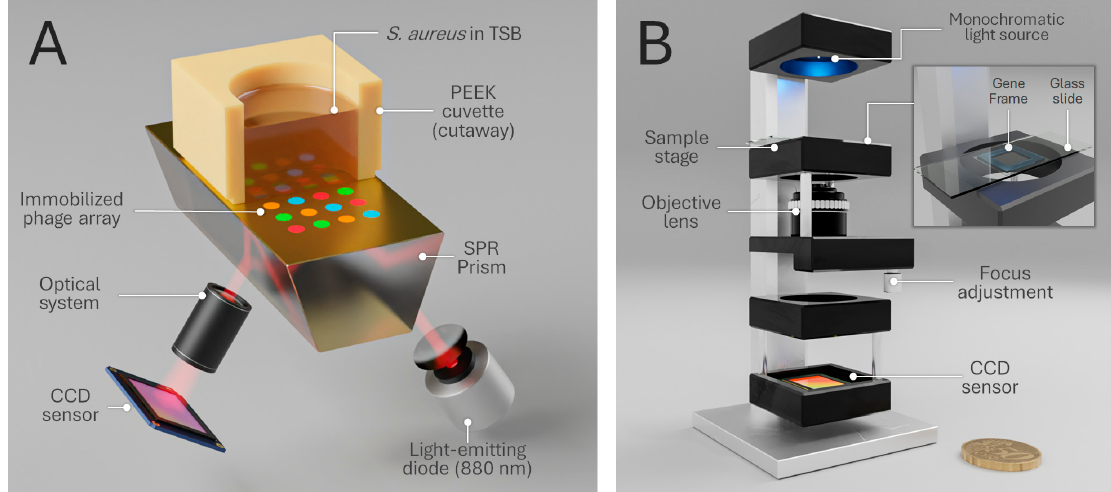
Figure 1. ( A ) A schematic illustration of the SPRi prism, functionalized with an immobilized array of phages, shown interfaced with a cutaway of the PEEK cuvette containing liquid cultures of the challenge strain Staphylococcus aureus . ( B ) A schematic illustration of the phase imaging microscope. Mounted on the sample stage is a co-culture of phage gh-1 and P. putida , sandwiched between a microscope cover slip, a gas-impermeable Gene Frame, and a microscope